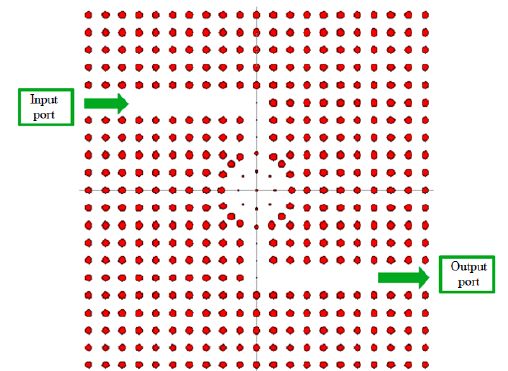
Fig. 4 Normalized transmission spectra of the proposed biosensor.